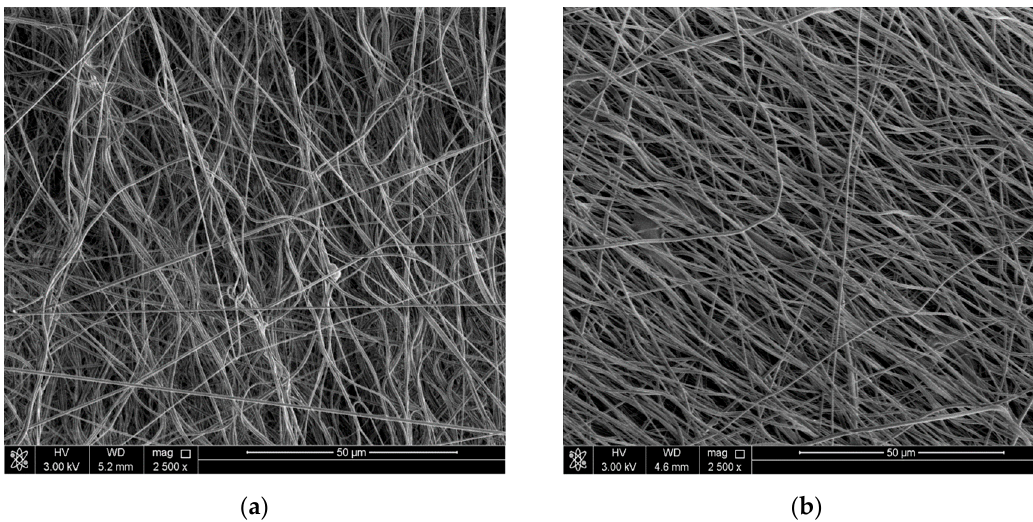
Figure 6. Images from SEM for neat GO ( a ) and GO-PBMA ( b ) based composite systems and their electrospun mats.